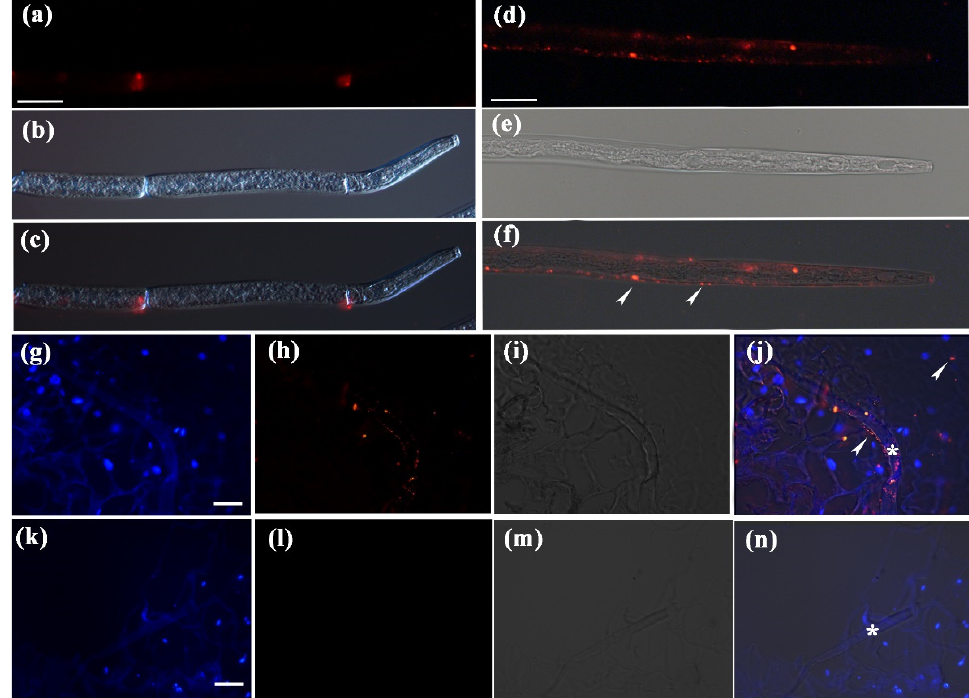
Figure 2. Localisation of Ab-FAR-1 protein in nematode and in planta. ( a – c ) No fluorescence signal was found when Ab-FAR-1 antibody was replaced by antiserum before immunization; Ab-FAR-1 protein secreted was located in the body wall of nematodes ( d – f ) and host cells ( g – j ) (white arrows). Micrographs ( a , d , h , l ) were observations of Alexa Fluor 594-conjugated secondary antibody. Micrographs ( g , k ) shows 4, 6-diamidino-2-phenylindole (DAPI)-stained nuclei. Micrographs ( b , e , i , m ) are images of differential interference contrast. Micrographs ( c , f , j , n ) were superpositions of images. The white arrows and asterisks indicate the location of the fluorescence signal and nematodes. Bar = 25 μ m.